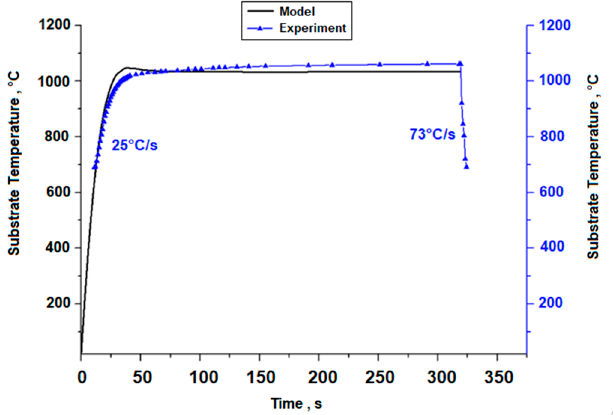
Figure 14. Comparison between the experimental data and the prediction coming from the simulation.